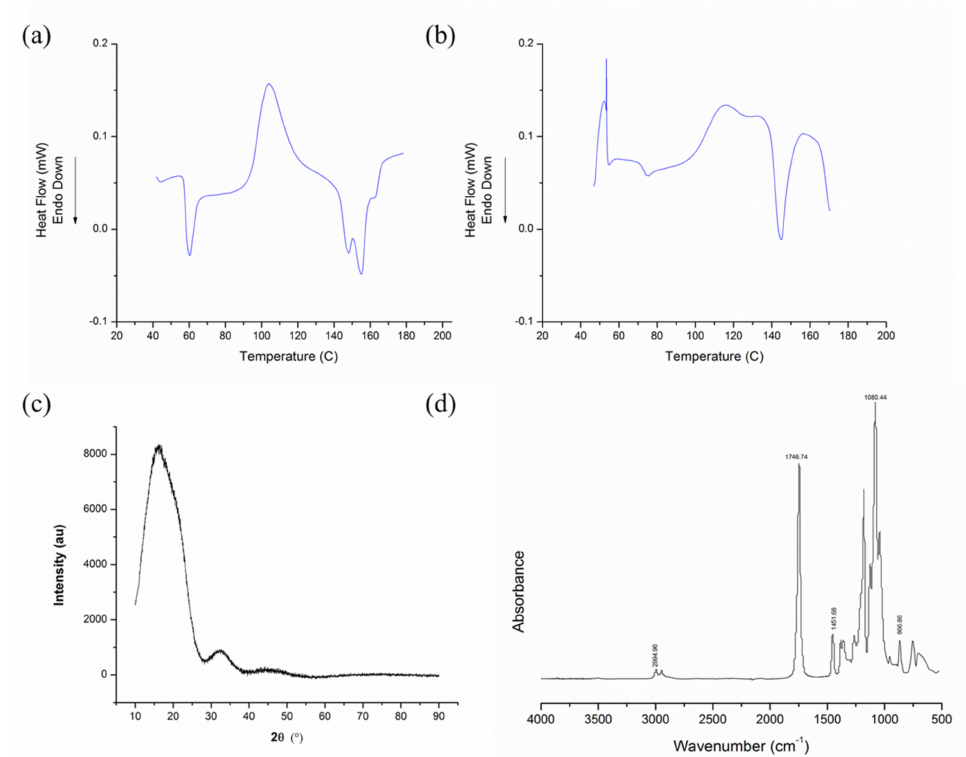
Figure 1. Characterization of unirradiated PLA. ( a ) Average DSC cycle 1; ( b ) average cycle 2; ( c ) XRD diffractogram; ( d ) FTIR spectra (labels: 2994.96, 1746.74, 1451.68, 1080.44, 866.86 cm − 1